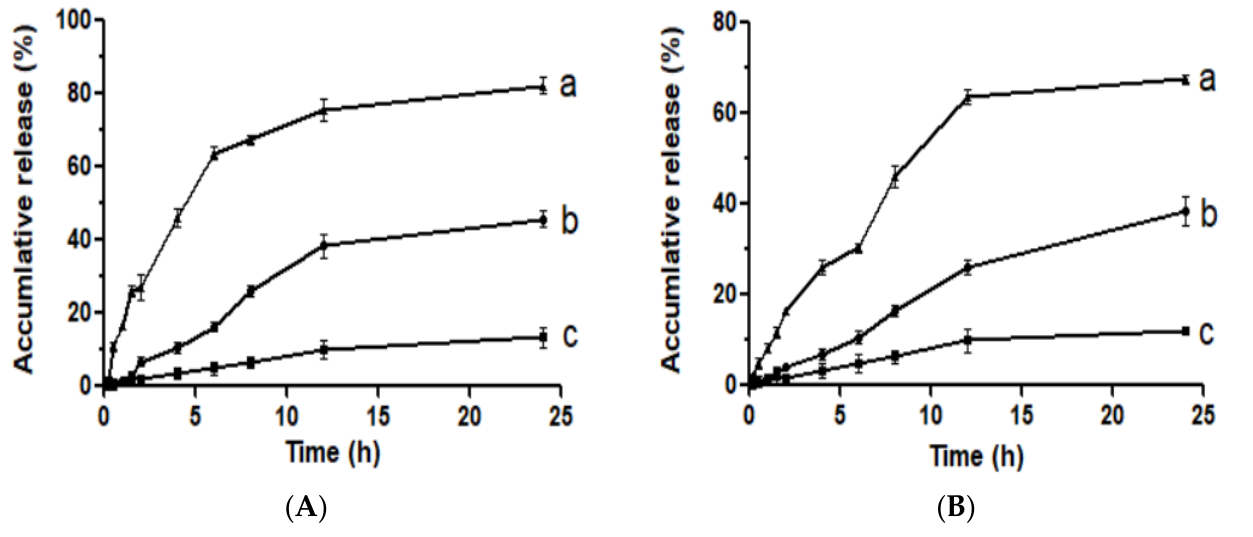
Figure 9. Dissolution profiles in the artificial gastric juice ( A ) and the artificial intestinal juice ( B ). (a) API nanoparticles, (b) API and HP- β -CD mixture, and (c) Raw API.